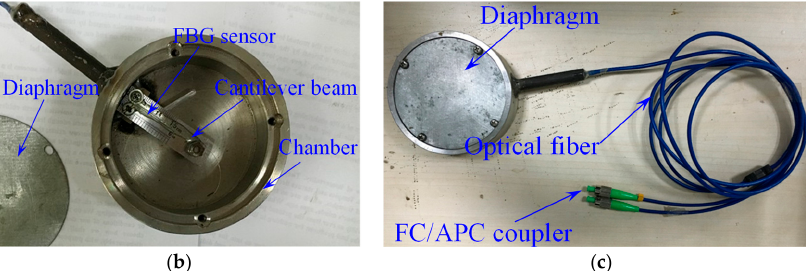
Figure 3. Schematic diagram of the fiber optic based earth pressure sensor (FPS) with combined diaphragm and cantilever beam: ( a ) schematic diagram of the newly designed FPS; ( b ) prototype of the designed FPS; ( c ) photograph of the packaged FPS.